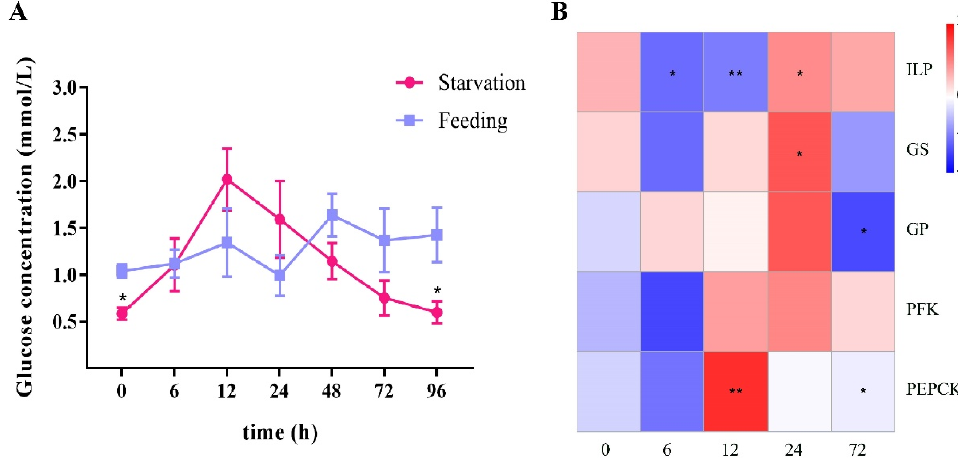
Figure 1. Effects of starvation treatment on hemolymph glucose and the expressions of LvILP and glucose metabolism genes in L. vannamei . ( A ) The variation curve of hemolymph glucose concentration during 4 days of starvation; error bars indicate the mean ± SD of three replicate samples. ( B ) Heatmap of the relative expression levels of LvILP , GS , GP , PFK , and PEPCK at different time points relative to the control group. The redder color indicates a higher expression level, and the bluer indicates a lower expression level. The numbers at the bottom represent the starvation time (h). The expression levels of the genes were detected by RT-qPCR, and 18 S rRNA was used as an internal reference. Statistical significances are shown as * p < 0.05 and ** p < 0.01.